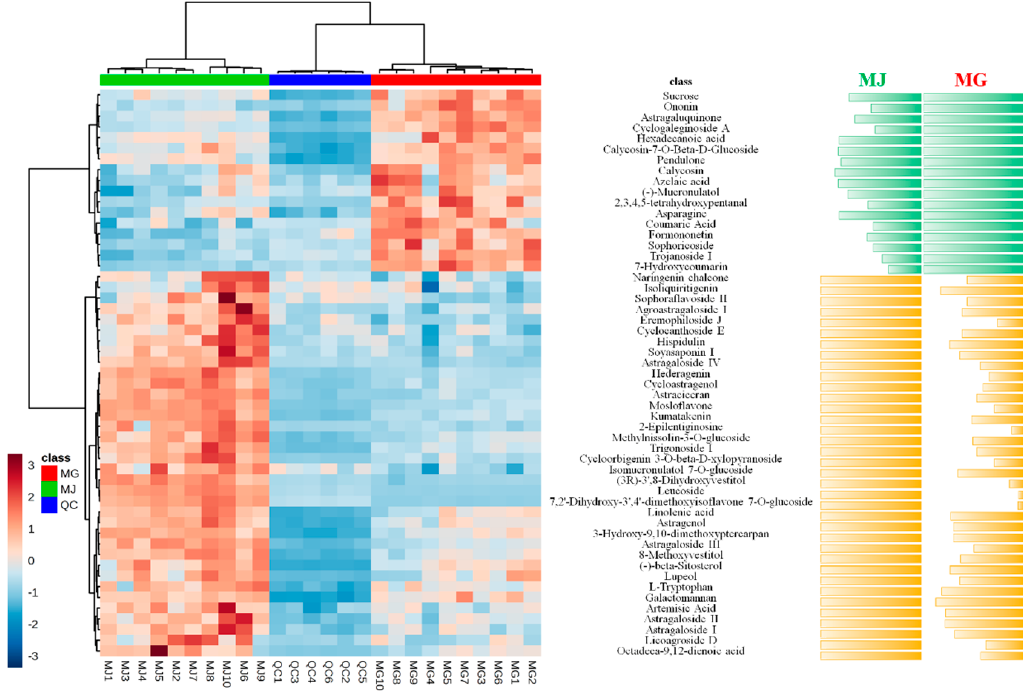
Figure 5. The heat map analysis and detail relative content comparison of chemical markers between MG and MJ.